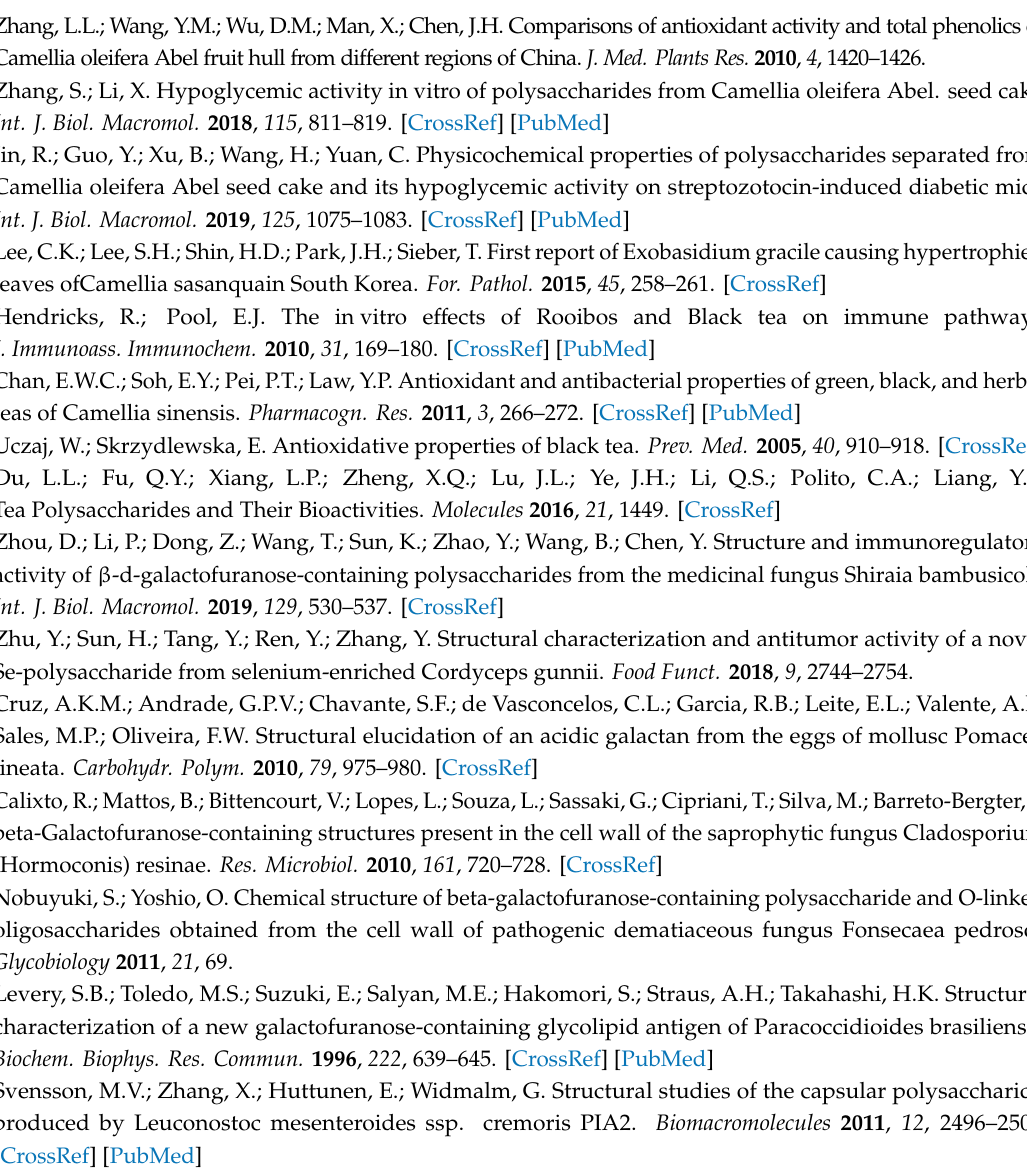
Figure S1: The free radical scavenging activities of the extracts and the polysaccharides from the normal leaves and the modified leaves. Table S1: General content of the sugar-related components from the extract of the normal and the modified leaves in Camellia oleifera . Table S2: Monosaccharide composition of leaves extract and the crude